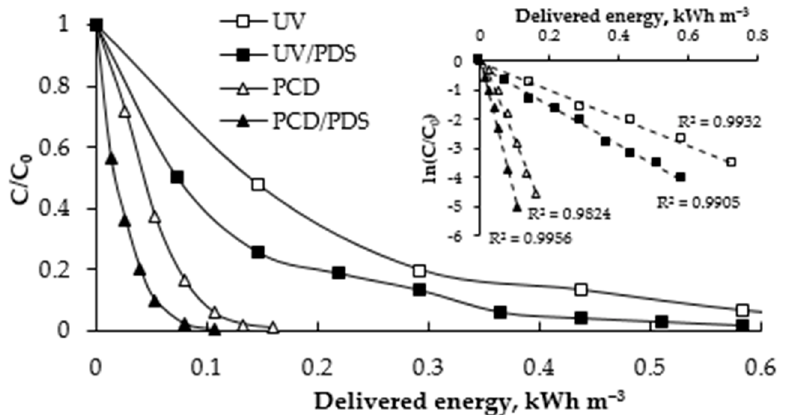
Figure 2. Degradation of VMN in UV photolysis, PCD treatment, UV/PDS, and PCD/PDS combina- tions ([VMN] 0 = 13.5 µM, [PDS] 0 = 67.5 µM, unadjusted